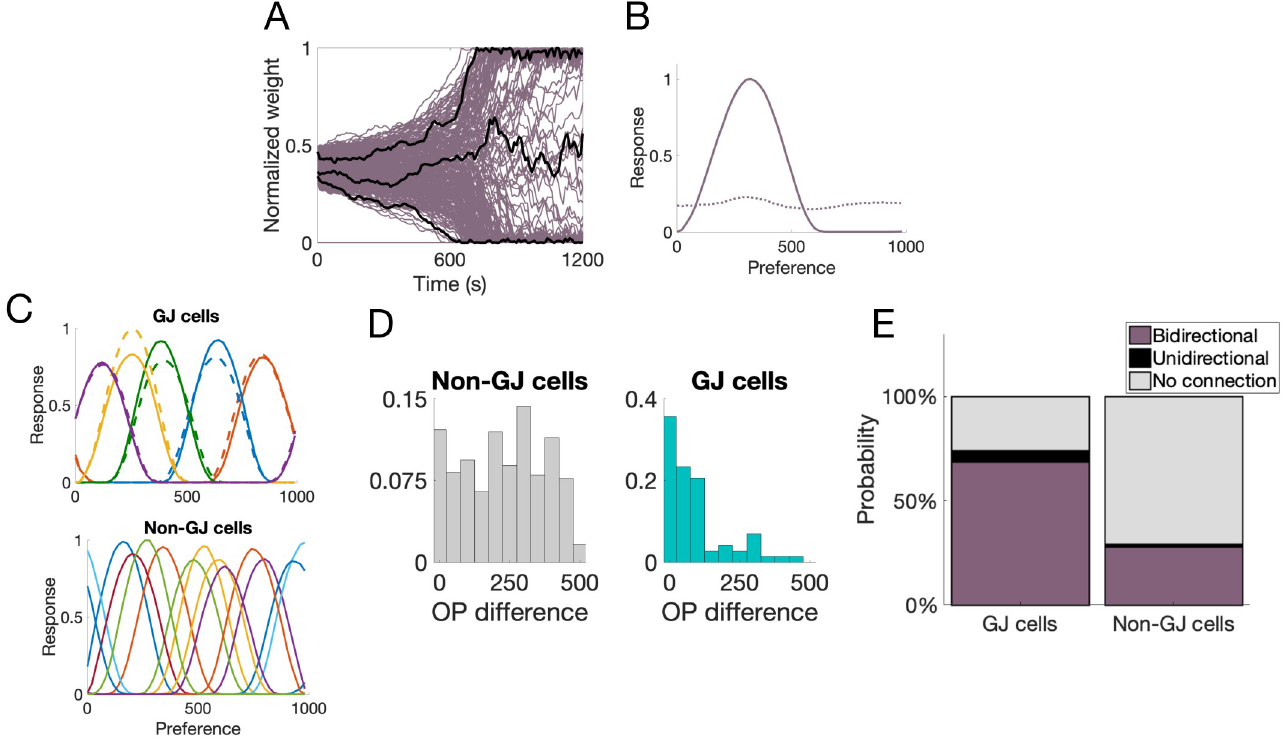
Fig 2. Measurements from a 400-neuron network with pairwise GJ coupling. A : Progression of the synaptic weights from LGN to one sample excitatory cortical cell. The black curves highlight three synapses that have potentiated, depressed, and remained around an average value; B : Tuning curve of this sample cell before (dotted curve) and after (solid curve) feedforward LGN synaptic learning. Recall that OP is labeled according to LGN input labels 0–1000; C : Sample tuning curves. (top) Tuning curves of five GJ-coupled pairs, where matching colors indicate the GJ-coupled pairs. (bottom) tuning curves of non-GJ-coupled excitatory cells; D : Distribution of the difference in OP between GJ-coupled pairs (teal) and non-GJ-coupled cells (gray); E : Probability of a bidirectional synapse (purple), a unidirectional synapse (black), or no synapse at all (gray) between GJ-coupled cells and non-GJ-coupled cells.